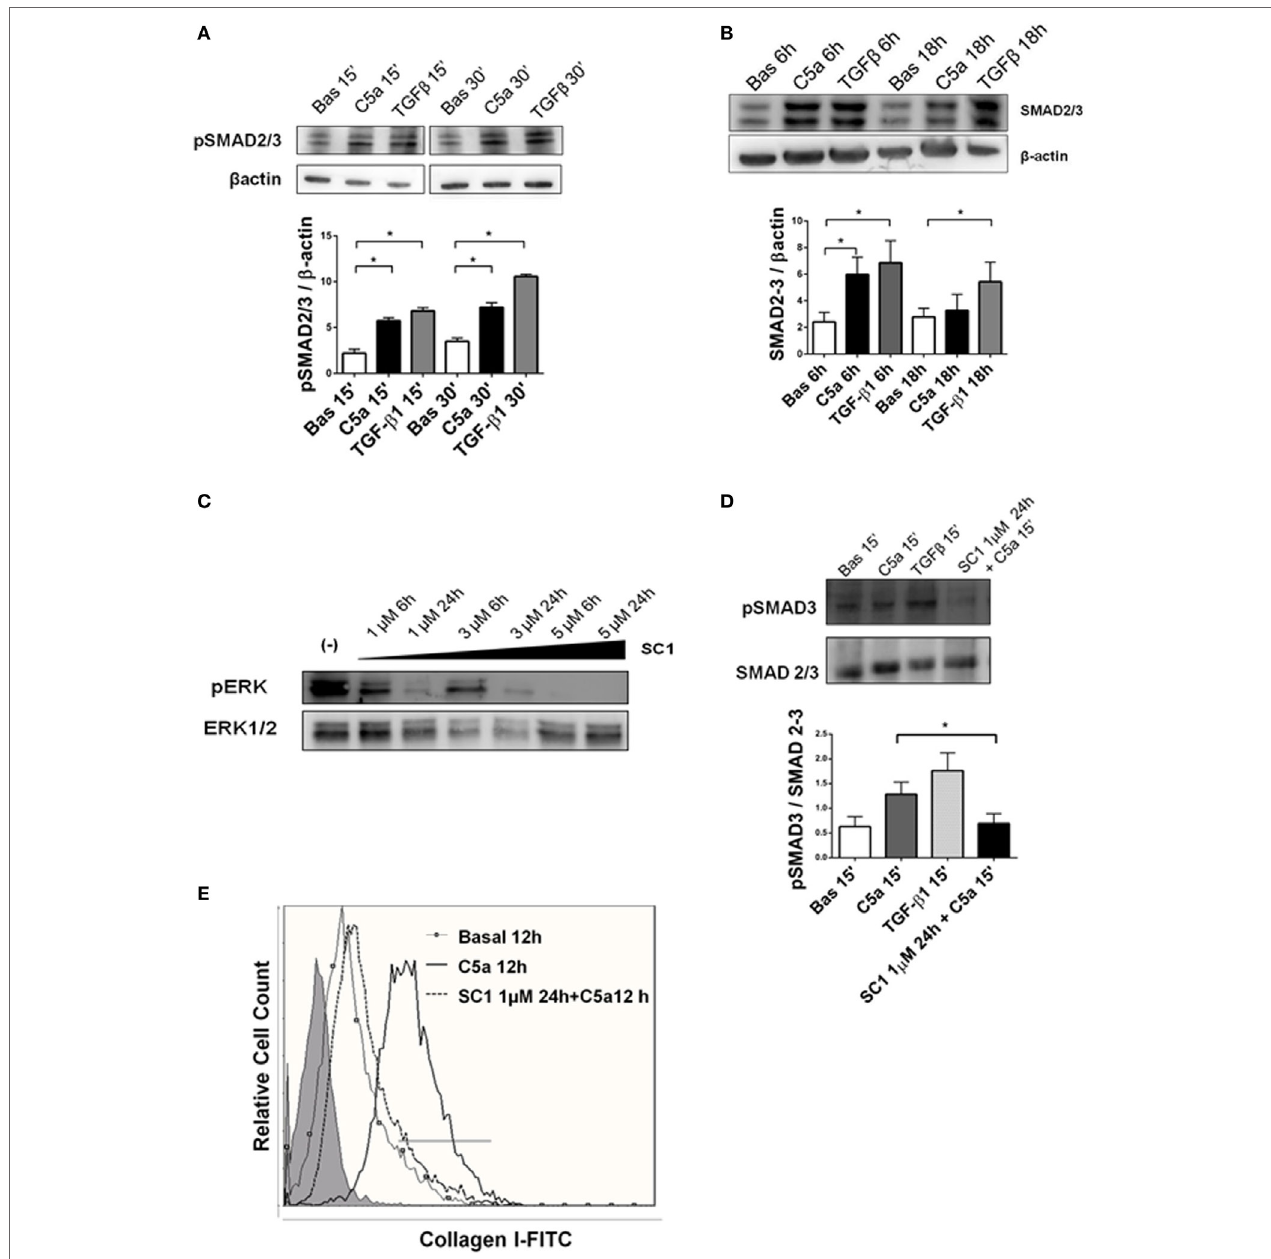
FigUre 9 | TGF β canonical pathway is activated by C5a and modulated by pERK. (a) Western blot of pericytes stimulated by C5a and TGF β . C5a increased the phosphorylation of SMAD 2/3 complexes after15 and 30 min (b) and upregulated the total SMAD 2/3 expression after 6 and 18 h. pSMAD2/3 and total SMAD 2/3-protein expression was normalized by β -actin. (c) Pericytes were cultured with or without SC1 (Pluripotin) pretreatment to inhibit extracellular signal-regulated kinases (ERK) phosphorylation. Time course of ERK phosphorylation at 6 and 24 h using increasing SC1 concentrations (1–3–6 µM) was performed. The relative density of the bands was normalized to total ERK. Pretreatment with SC1 1 µM for 24 h blocked C5a-induced SMAD3 phosphorylation after 15 min of incubation and the C5a-induced collagen I production after 12 h. (D,e) . Expression levels of pSMAD 3 were normalized by total SMAD. Graphs show mean ± SD, n =